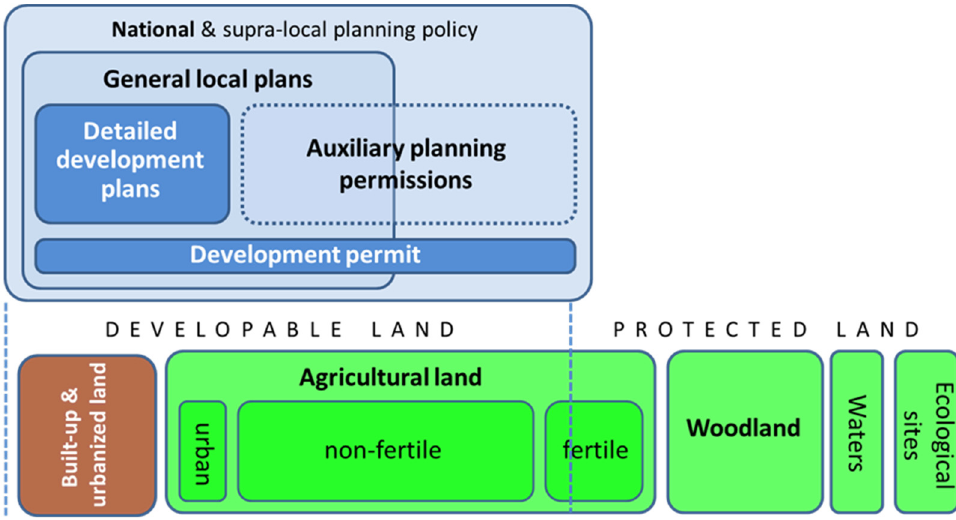
Table 1. The comparison of the key features of the investigated frameworks of developable land designation management. Key Features of